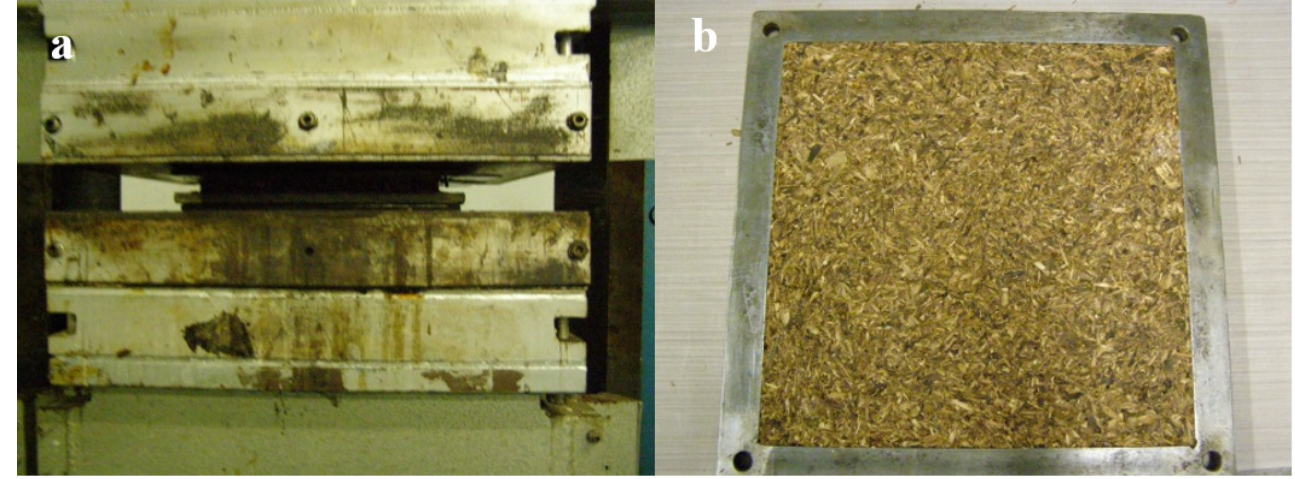
Figure 2. ( a ) Hot pressing of particleboard. ( b ) Pressed board still in the iron mold.